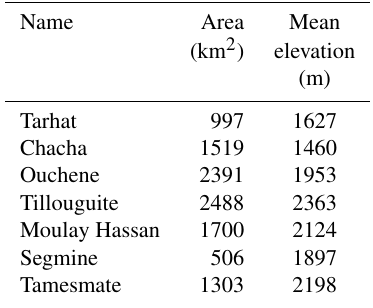
Table 2. Characteristics of the seven analysed